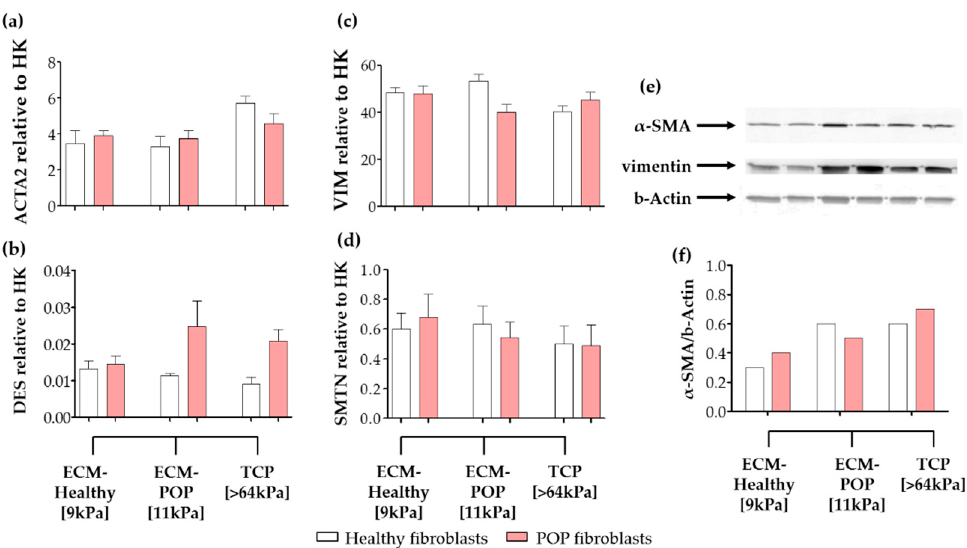
Figure 4. Expression of intracellular proteins of vaginal fibroblasts on different micro-environments. Healthy or POP fibroblasts were seeded for 48 h on different micro-environments: ECM-Healthy (vaginal decellularized extracellular matrix from healthy tissues), ECM-POP (vaginal decellularized extracellular matrix from pelvic organ prolapse tissues) or tissue culture plates (TCP). Relative gene expression to house-keeping genes (HK) of: ( a ) ACTA2 (alpha smooth muscle actin or α -SMA), ( b ) DES (desmin), ( c ) VIM (vimentin) and ( d ) SMTN (smoothelin). ( e ) Western blots showing protein levels of α -SMA, vimentin and b-actin. ( f ) Corresponding quantification of the density of the bands of α -SMA normalized to b-actin. Data represents the mean ± SD. * p < 0.05, ** p < 0.01, *** p < 0.001 by one-way ANOVA, followed by Tukey’s multiple comparison test.